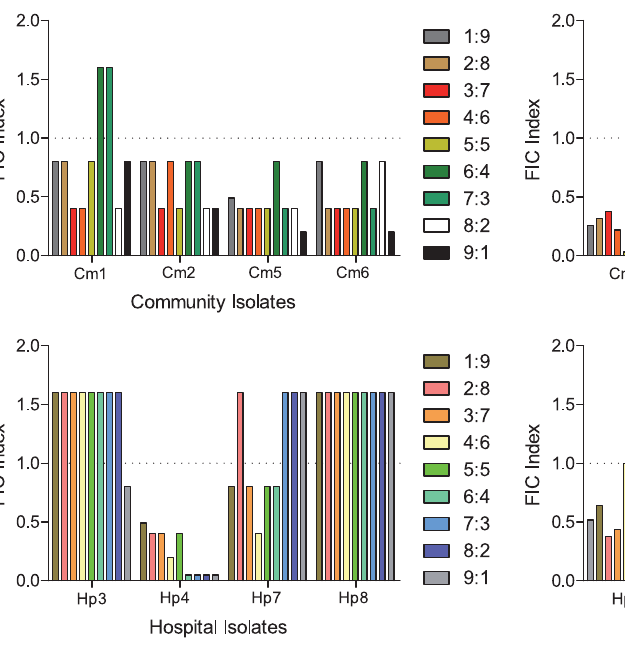
FIGURE 4. Susceptibility of ESBL Isolates to Gentamicin- Cefuroxime antibiotics cocktail Varying proportions of Gentamicin and Cefuroxime antibiotics ranging from 1:9 to 9:1 were mixed according to the continu- ous variation checkerboard method and seeded into Mueller Hinton agar. The ESBL producing organism was streaked on the surface of the agar plate. The set up was done in triplicate with a control containing no antibiotics and these were incu- bated at 37 o C for 24 hours and observed for growth. The MICs of the various combinations were determined and interactions between the antimicrobial agents were assessed by determin- ing their Fractional Inhibitory Concentration [FIC] index ratios where FIC index value below unity signi fi es synergism, ≥ 1 ; indifference, and ≥ 2; antagonism (Cm1, Cm2, Cm5, and Cm6 represent community isolates, while Hp3, Hp4, Hp7, and Hp8 represent hospital isolates